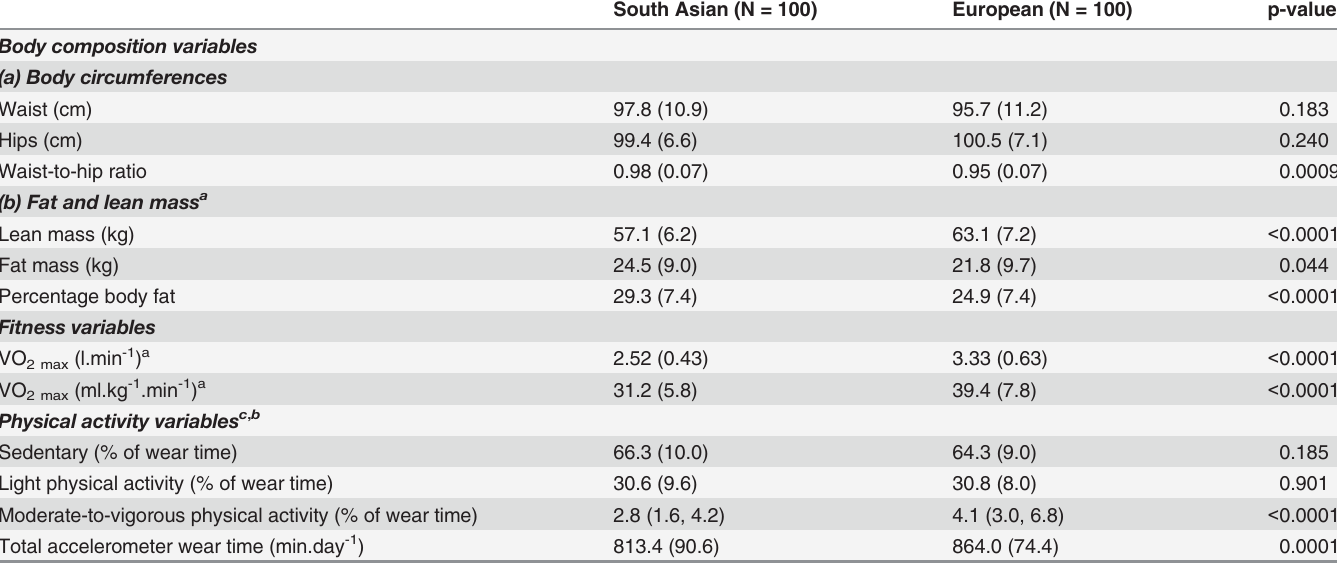
Table 2. Body composition, fitness, and physical activity variables for all South Asian and European men.